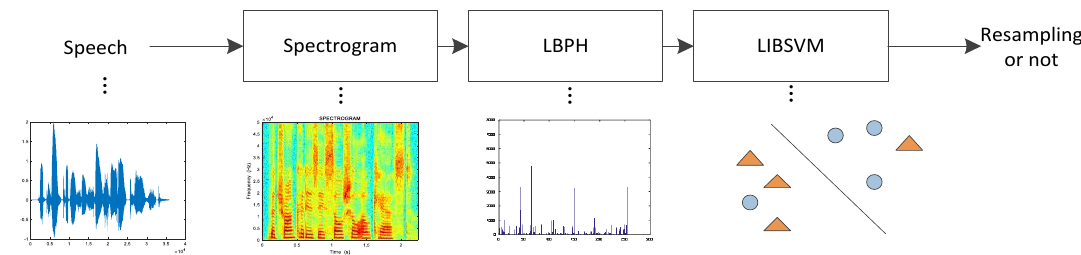
Figure 6. Proposed speech resampling detection process.